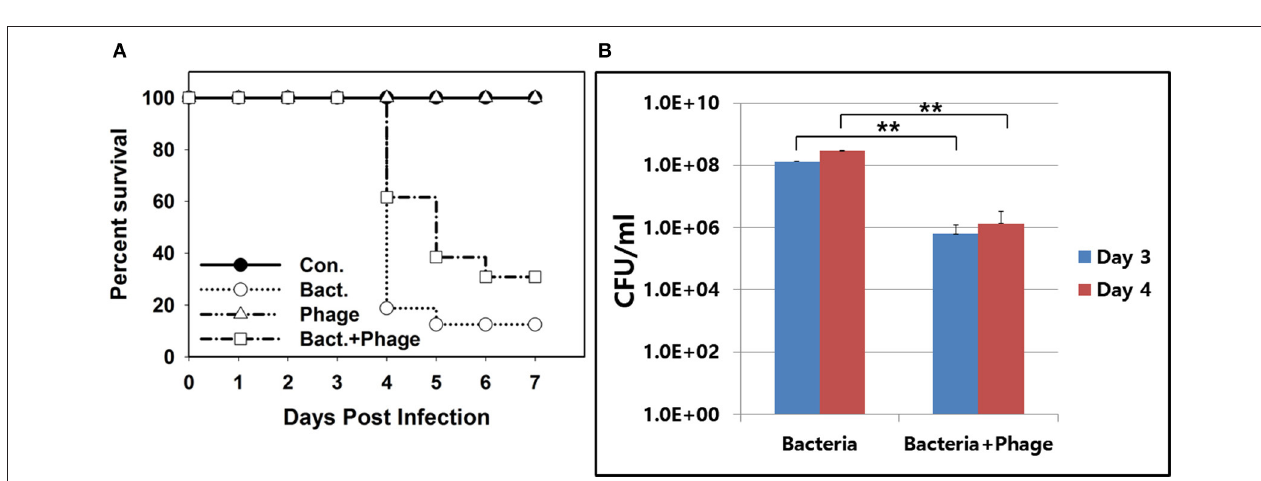
FIGURE 5 | Genomic tree of Acinetobacter phages found in GenBank. The tree was drawn based on each phage’s DNA polymerase gene sequence using Mega 7.